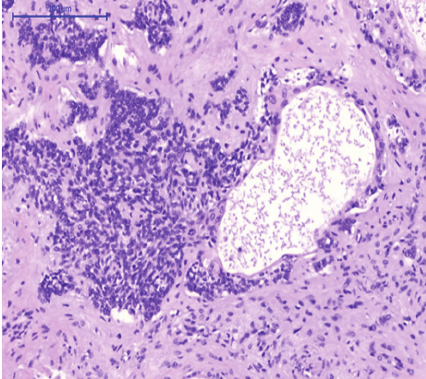
Figure 2: HE-staining. Hepatic BSCC showing basaloid cells with hyperchromatic nuclei and scant cytoplasm. The tumor cells are arranged in solid islands and strands with peripheral palisading.